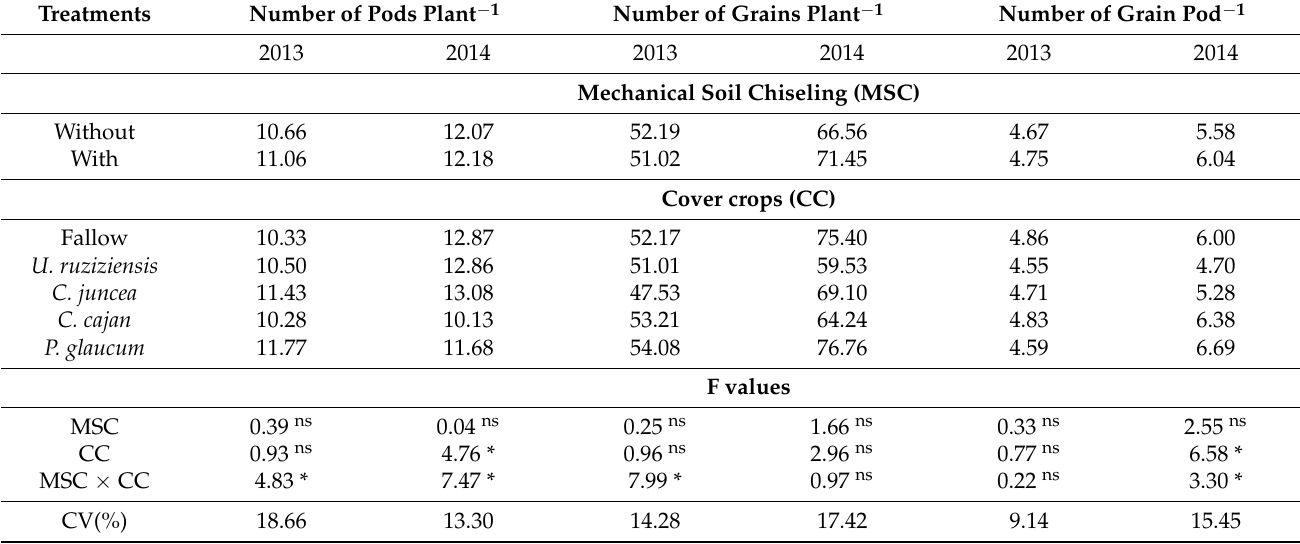
Table 3. Mean values of number of pods and grains plant − 1 and number of grains pod − 1 of “win- ter” common beans after mechanical chiseling and predecessor cover crops, Selv í ria, MS,